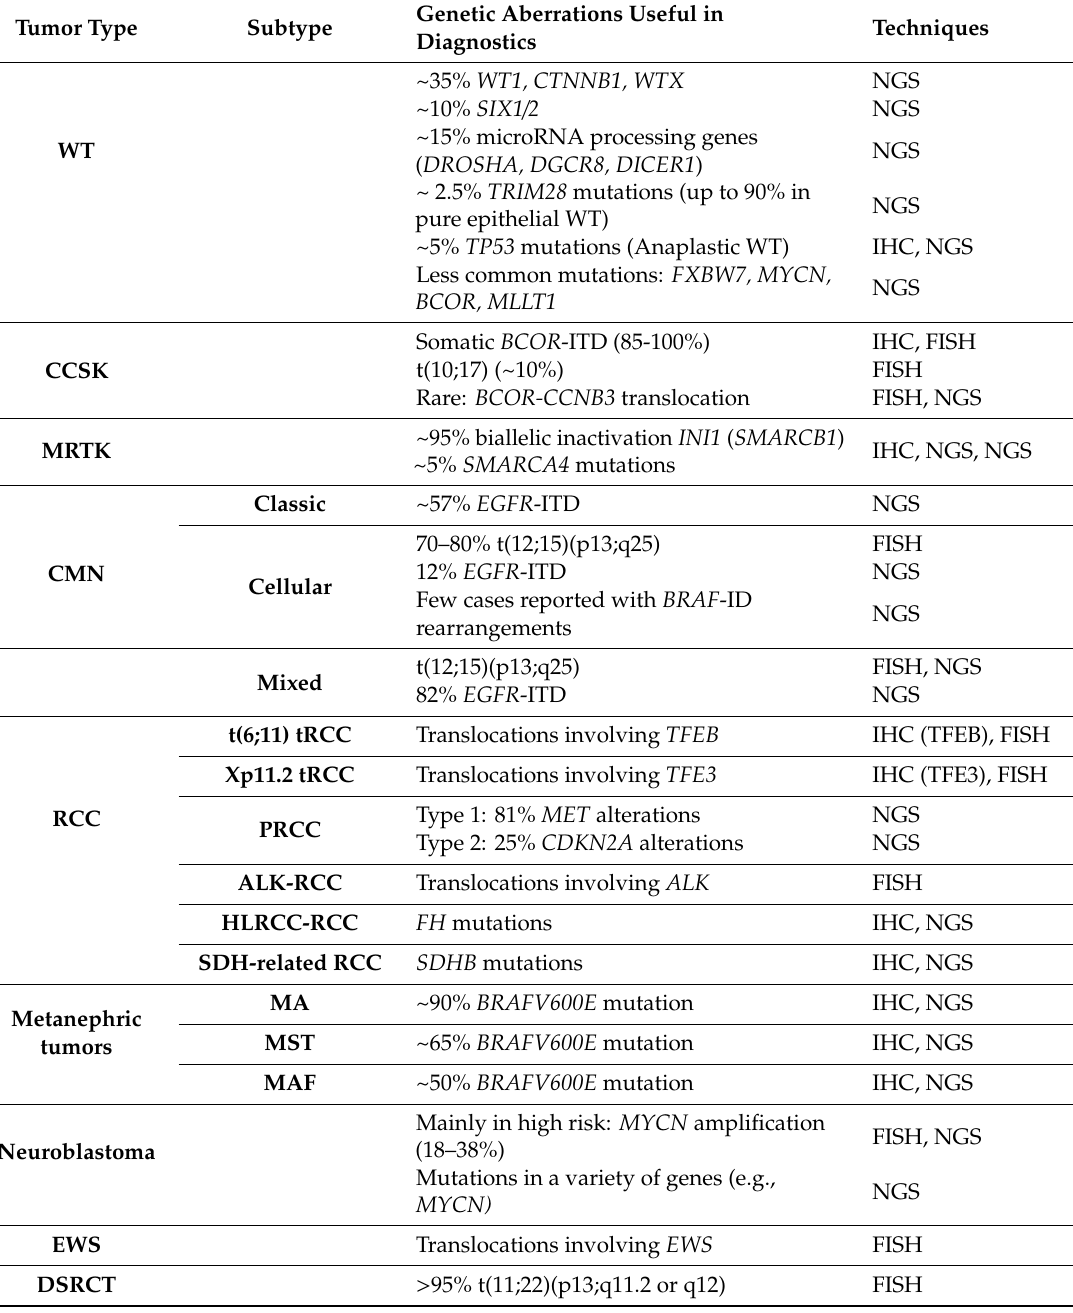
Table 5. The most common genetic aberrations useful in the di ff erential diagnoses of pediatric renal